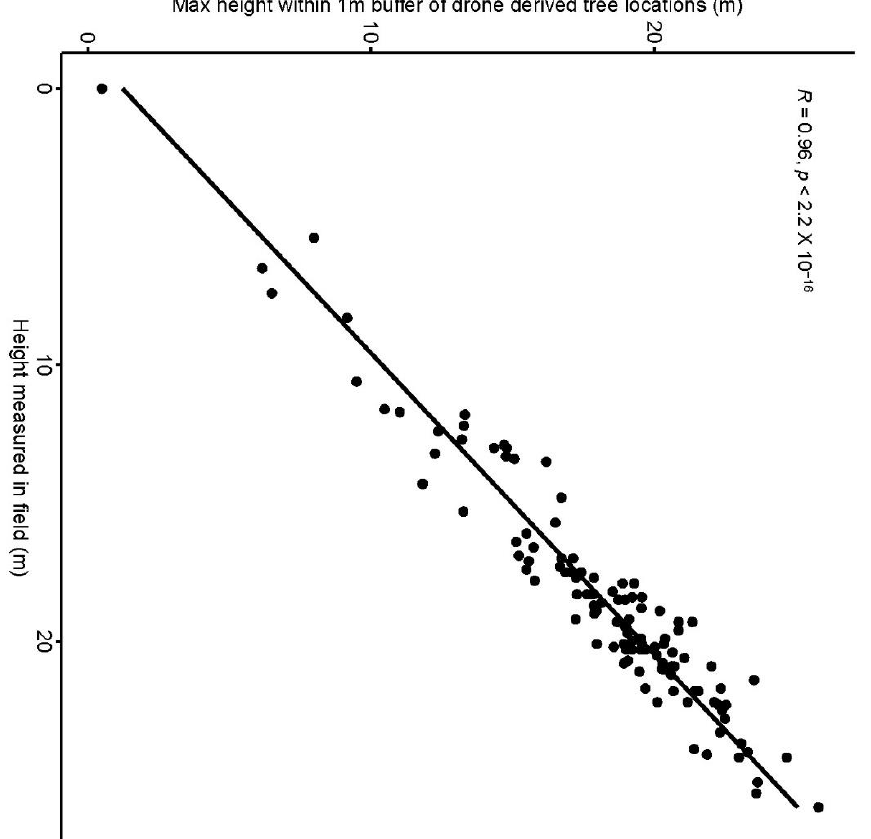
Figure 12. Relationship and statistical test between field-measured and drone-derived tree heights.